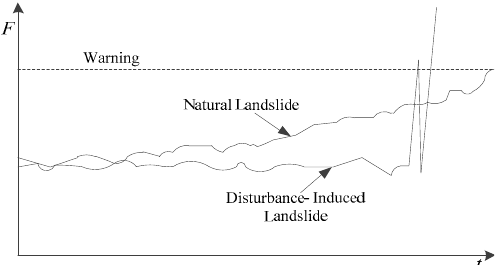
Figure 2. Evolution law of the sliding force for the natural landslide and disturbance-induced landslide.